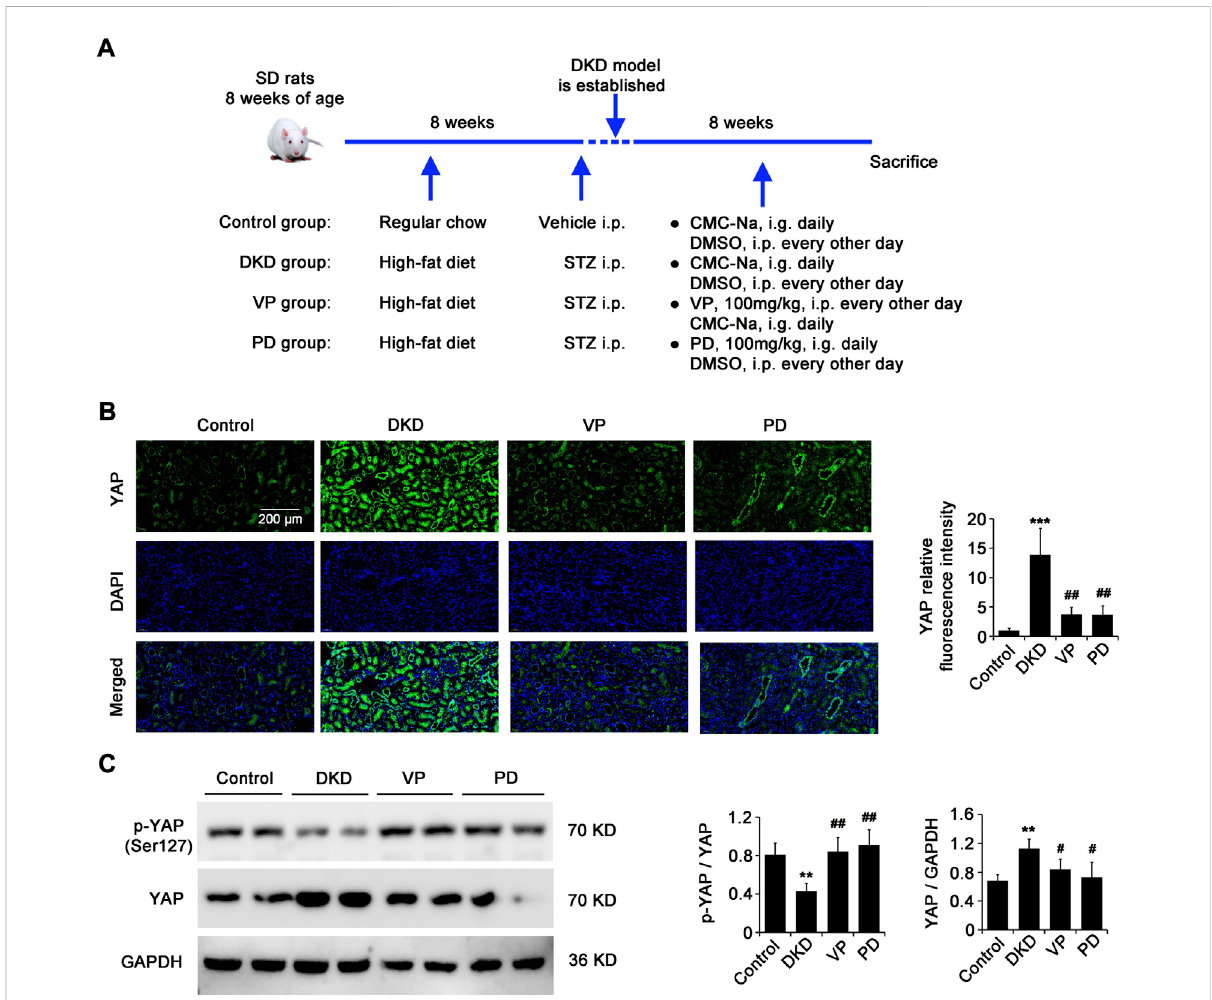
FIGURE 5 PD is similar to VP in inhibiting the expression and nuclear translocation of YAP in kidneys of DN rats. (A) Immediately after modeling, DKD rats were treated with PD (100 mg/kg, i.e. daily) or VP (a pharmacological inhibitor of YAP, 100 mg/kg, I. p. every other day) for 8 weeks. Age-matched healthy rats and DKDrats treated with equivalentvehicle wereused as negative control (control group) and model control (DKD group) respectively. (B,C) The renal expression and nuclear translocation of YAP in DKD rats were captured by CLSM (B) and western blot (C) . DKD, diabetic kidney disease; VP, vertepor fi n; PD, polydatin; STZ, streptozocin; CMC-Na, sodium carboxymethylcellulose; DMSO, dimethyl sulfoxide; YAP, Yes- associated protein; p-YAP, phospho-YAP; DAPI, 4 ’ ,6-diamidino-2-phenylindole; α -SMA, alpha-smooth muscle actin; DAPI, 4 ’